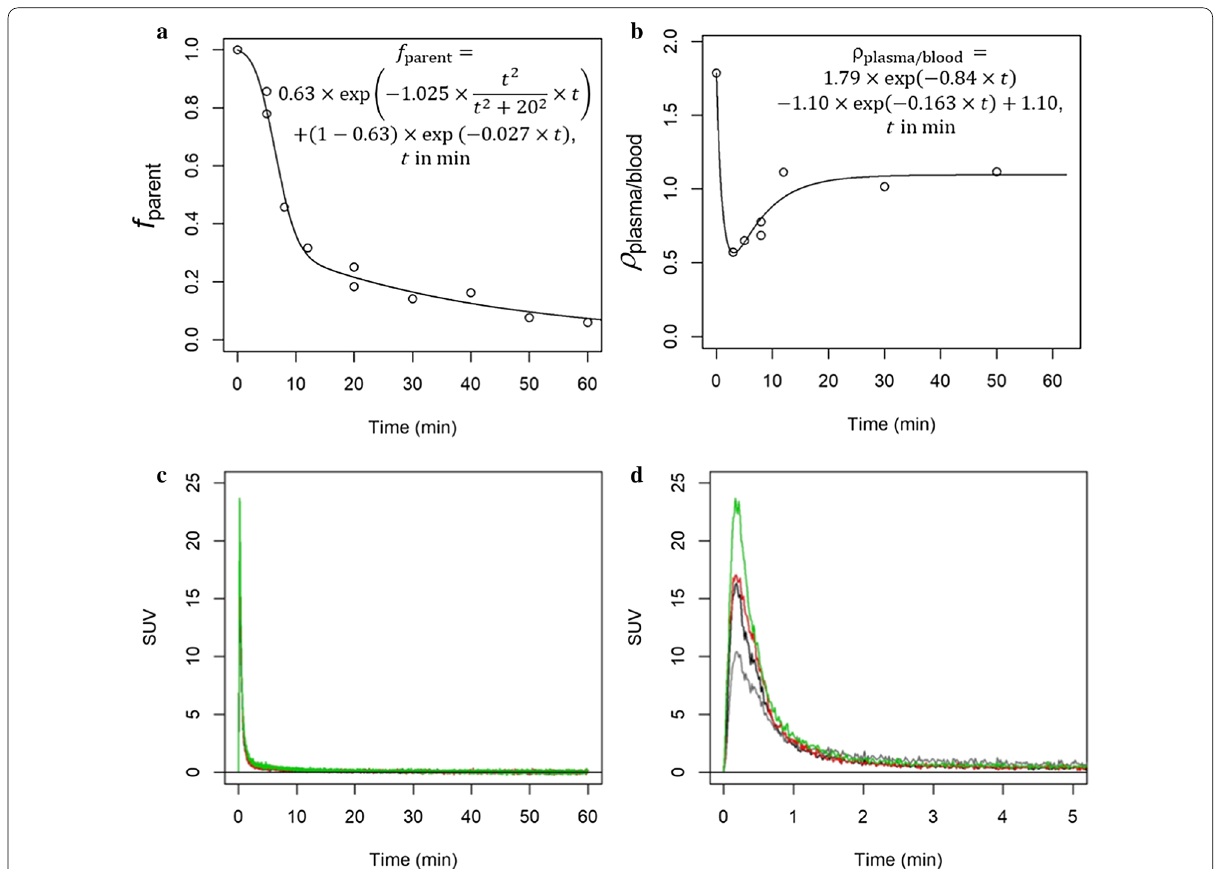
Fig. 5 Generation of the input function. a Radioactivity fraction of parent tracer in plasma over time. b Ratio of activity concentration between plasma and whole blood over time. Lines are fit functions according to Eqs. 1 and 2, respectively, and as shown in the graphs. c Generated normalized (SUV) input functions of the 3 scans with blood coincidence measurements. d as c , emphasizing the first 5 min. Black, red, green, input functions; grey (lowest peak), whole blood SUV corresponding to the black input function (second lowest